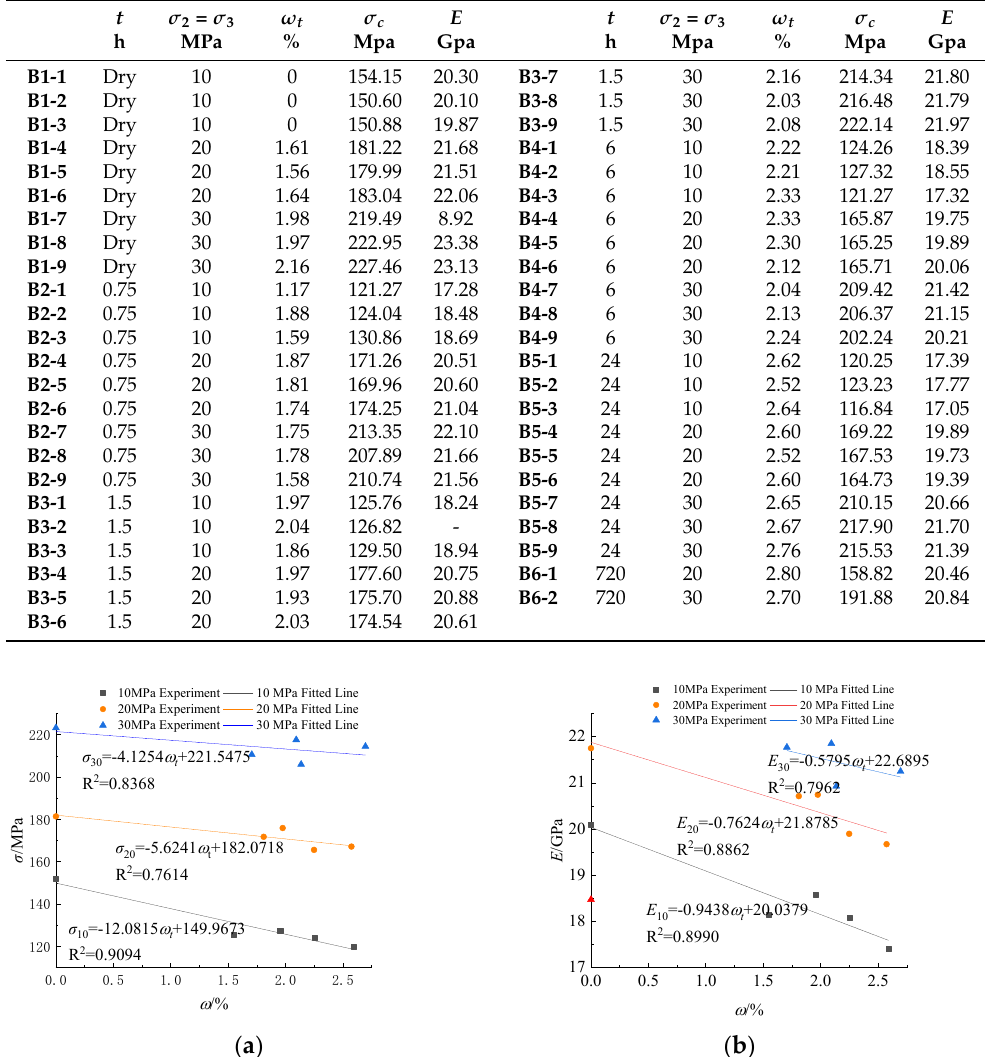
Figure 6. The correlation between the water content and the mechanical parameter in uniaxial test. ( a ) σ - ω ; ( b ) E - ω . Table 2. The rock mechanical parameters in triaxial compression tests.